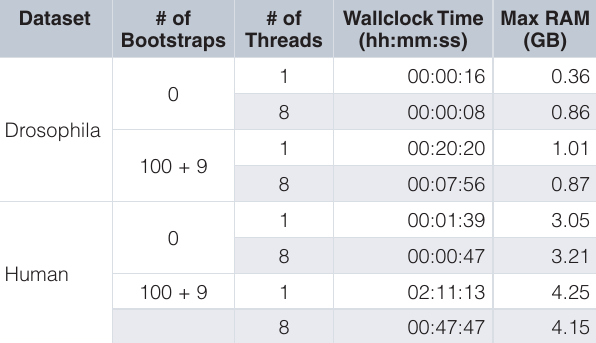
Table 5. Runtime and maximum RAM usage for the Drosophila and human simulated datasets, running on a hyper-threaded quad-core 15” 2015 Macbook Pro with SSD and 16GB RAM. Measured via the peakRAM package 36 . For the bootstrapped runs, 100 iterations were used for the quantification reproducibility and 9 for the cross-replicate reproducibility, representing all the pairwise combinations of the 3 replicates per